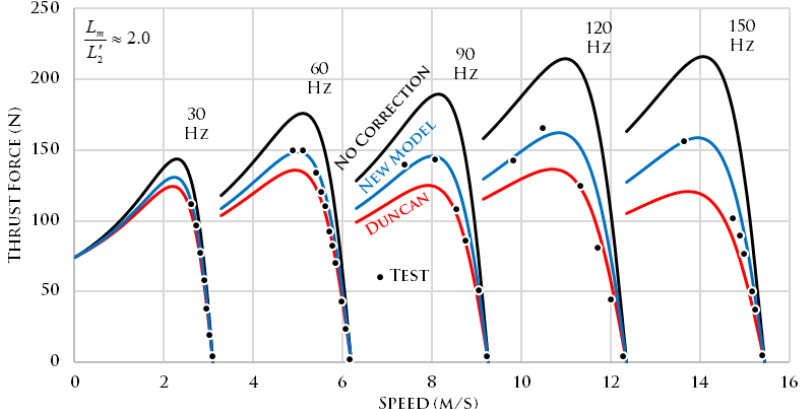
Figure 14. Comparison of thrust force through frequency variation (UD). Average gaps in ascending order [mm]: 3.89/3.99/4.11/4.23/4.24.